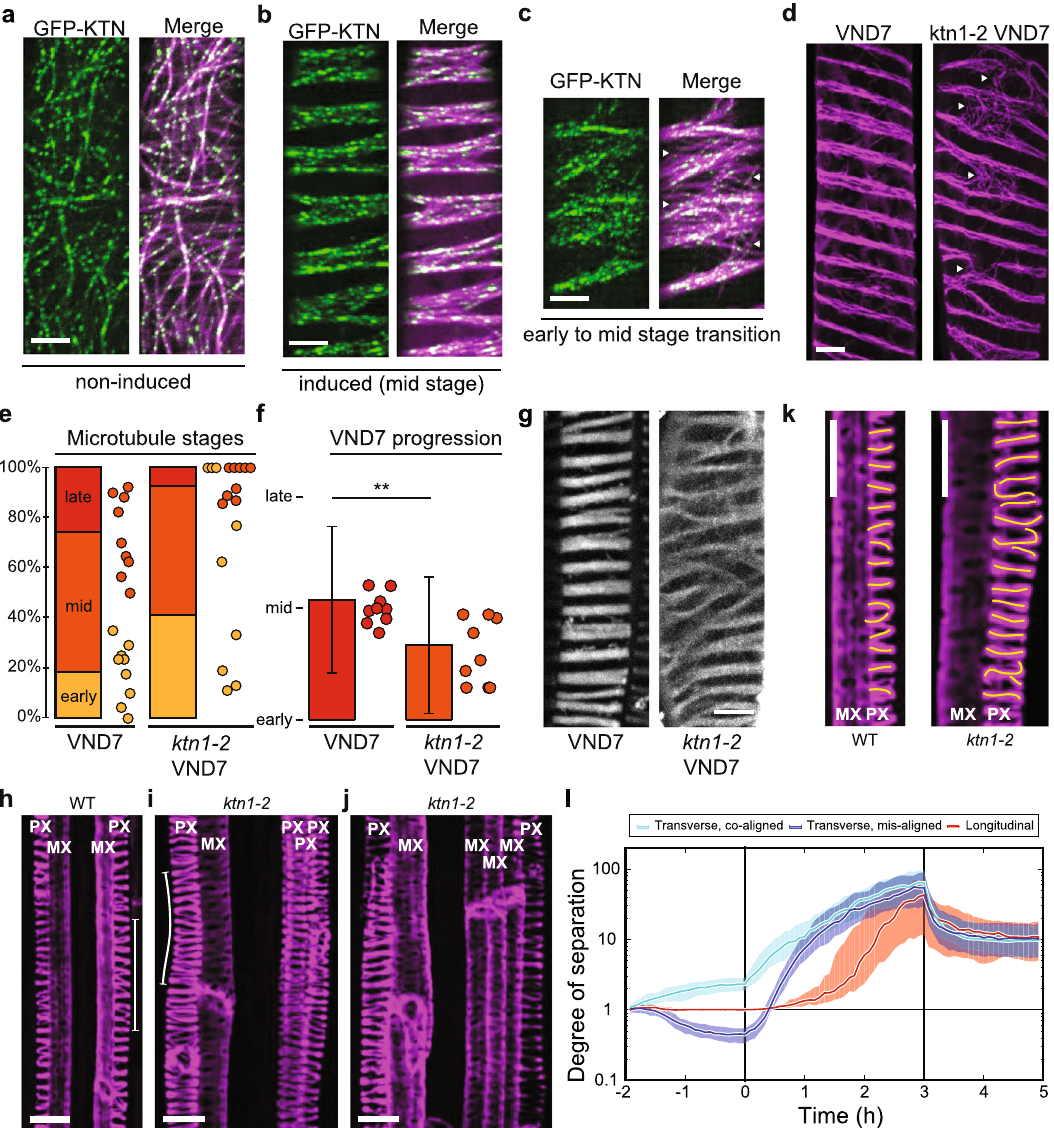
Fig. 4 Fidelity and speed of microtubule band formation depends on KATANIN. a – c Maximum projection of dual-labelled mCh-TUA5 and GFP-KTN seedlings in non-induced cells ( b ) and during PX formation ( b , c ). KTN1-GFP localizes majorly to forming microtubule bands during early ( b ) and mid ( b ) stages of PX formation. Scale bars = 10 µ m. d Maximum projections of mCh-TUA5 VND7 during PX formation in wild-type (left) and in ktn1-2 (right). Arrowheads in c and d point toward regions with incomplete band separation. Scale bar = 5 µ m. e Fraction of cells classi fi ed into early, mid and late stages of PX formation for induced mCh-TUA5 VND7 (left) and ktn1-2 VND7 (right). Dots depict fractions of early and mid-stages of nine seedlings for each genotype. f Relative progression of VND7 (left) and ktn1-2 VND7 (right). Microtubule arrays in VND7 are signi fi cantly more progressed (2.1 ± 0.7, mean ± SD, 174 cells from 9 seedlings) compared to the ktn1-2 VND7 (1.7 ± 0.6, 127, 9, ** p = 0.0042, Welch ’ s unpaired, two-sided t -test). Dots depict VND7 progression for nine seedlings for each genotype. g Maximum projection of stained secondary walls of induced wild type (left) and ktn1-2 (right) 48 h after induction. Scale bar = 10 µ m. h – k Basic Fuchsin-stained wild-type (h) and ktn1-2 (i-j) xylem fi les in 6-day-old roots. In ktn1-2 , an altered arrangement of PX ( i ) and MX ( j ) vessels is observed, PX vessel thicknesses vary (compare vertical lines in h and i ) and cell wall bands are wider and more disordered ( k , right) as compared to wild type ( k , left). Band shapes are indicated by yellow lines. Scale bars = 10 µ m. l Band separation is fastest for initially co-aligned transverse arrays (cyan and blue) and slowest for initially longitudinal arrays (red). Simulations assuming default parallel nucleation and no KTN activity ( r x = 0 s − 1 ). Lines and margins represent medians ± 16% and 84%